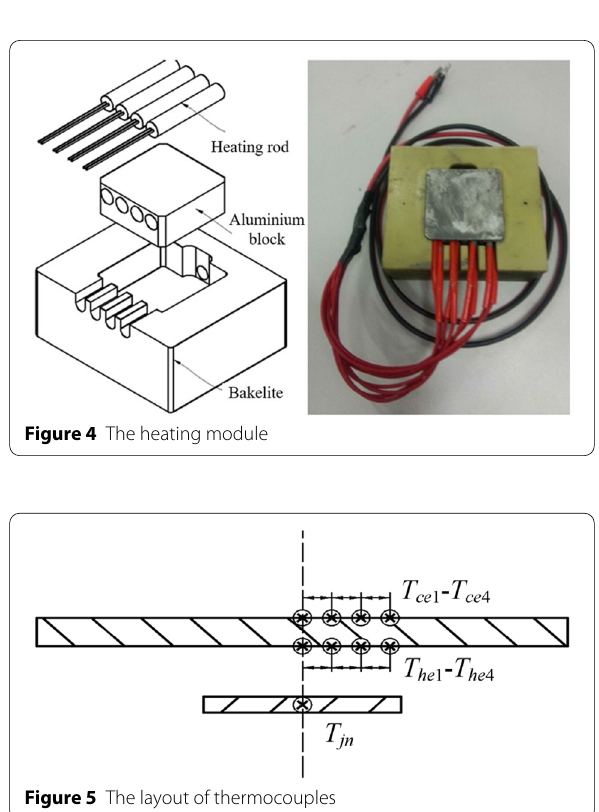
Figure 5 The layout of